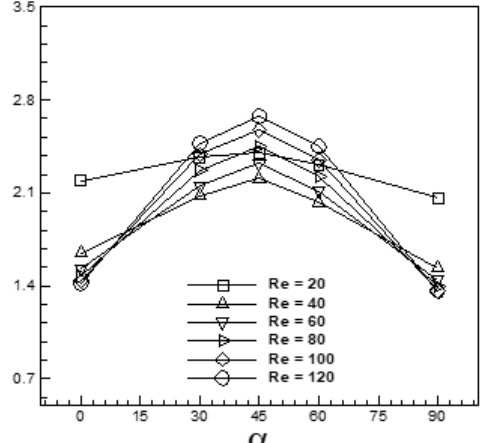
Figure 27. Variation of the mean/steady drag coefficient with free-stream orientation for the condi-